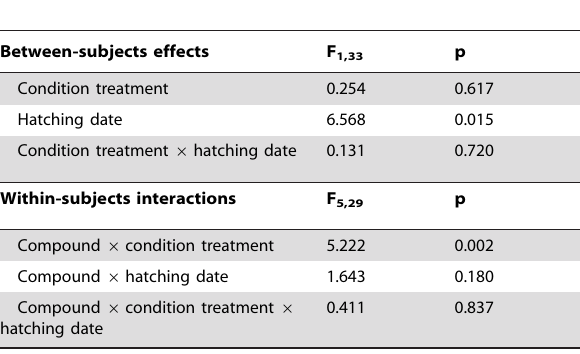
Table 2. Effect of female nutritional condition on cuticular hydrocarbon profiles.